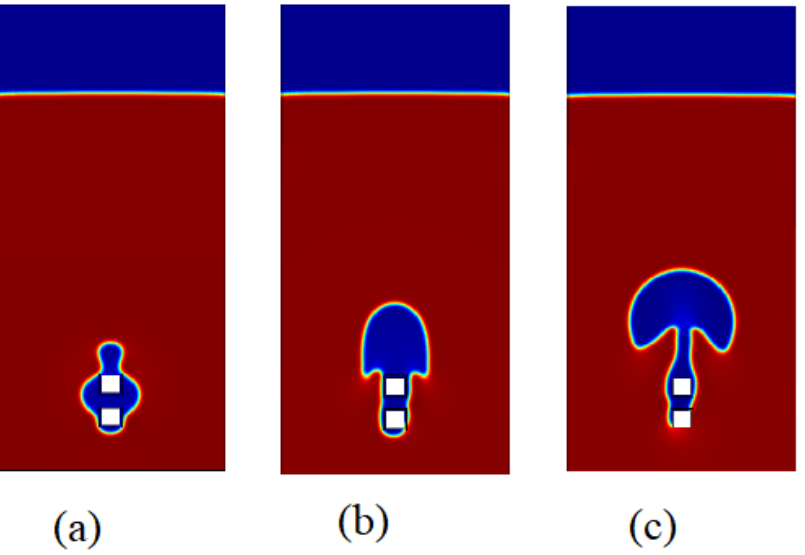
Figure 13. Bubble growth in vertical arrangement.